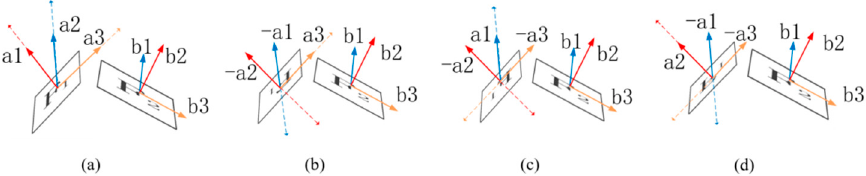
Figure 7. Potential registration schemes between 2 fracture surfaces. F1 and F2 represent different fracture surfaces, and their direction of the text reflects the order of registration. ( a ) The potential (cid:104) registration scheme where 𝑀𝐴 (cid:3404) (cid:4670)𝑎 (cid:2869) 𝑎 (cid:2870) 𝑎 (cid:2871) (cid:4671) , 𝑀𝐵 (cid:3404) (cid:4670)𝑏 (cid:2869) 𝑏 (cid:2870) 𝑏 (cid:2871) (cid:4671) ; ( b ) The potential registration scheme where MA = a